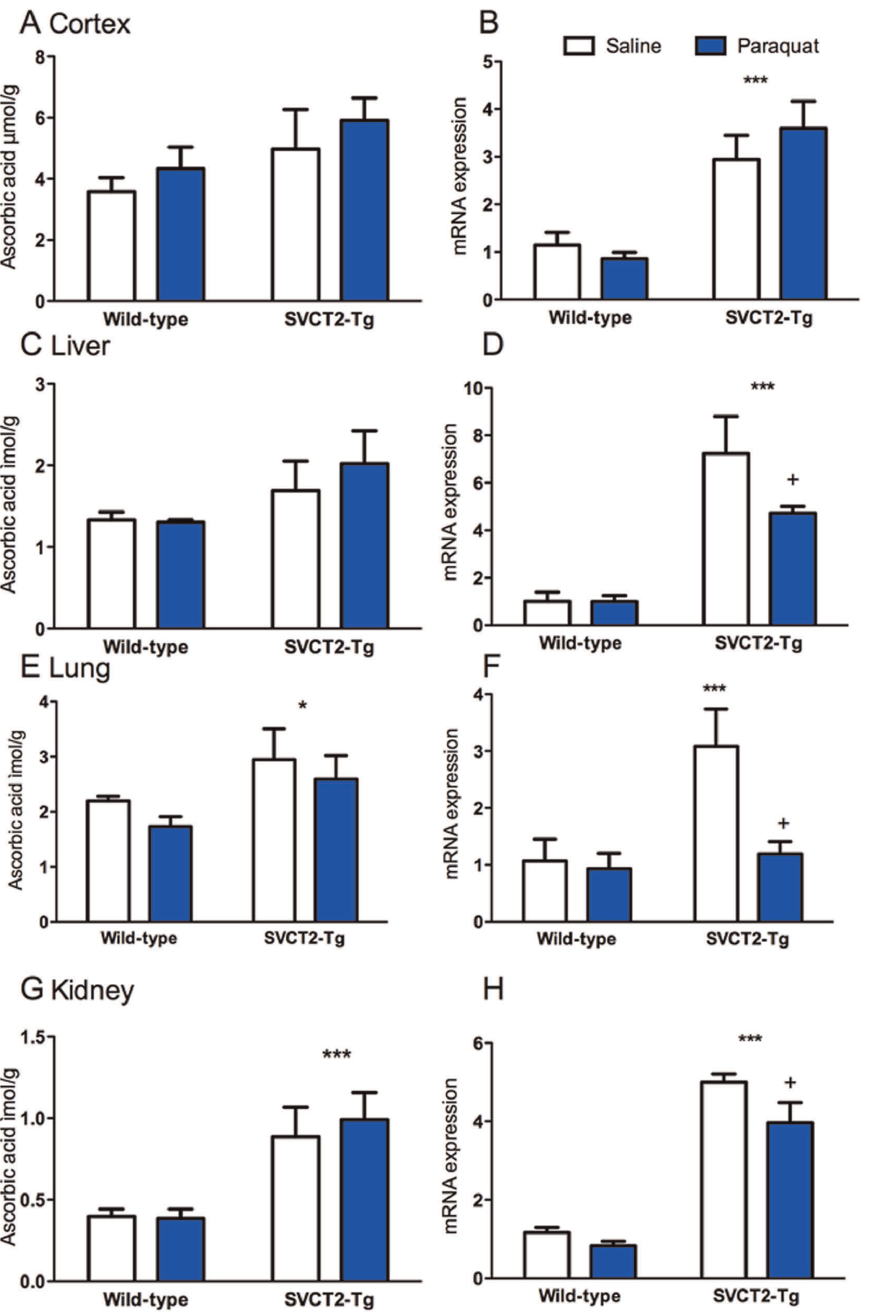
Figure 7. Ascorbic acid and mRNA levels following paraquat treatment. ASC was increased in (A) cortex, (C) liver, (E) lung, and (G) kidney, although this difference was only significant in lung and kidney. SVCT2 mRNA was significantly higher in SVCT2-Tg mice in (B) cortex, (D) liver, (F) lung, and (H) kidney, but significant decreases were found in PQ-treated mice compared to saline treated SVCT2-Tg mice. *, *** p , 0.05, 0.001 different from wild-type control; + PQ-treated mice different from saline-treated mice of same genotype. Data shown are mean + S.E.M for wild-type and SVCT2-Tg mice treated with saline (white bars) and paraquat (blue bars). N=5 mice per group.